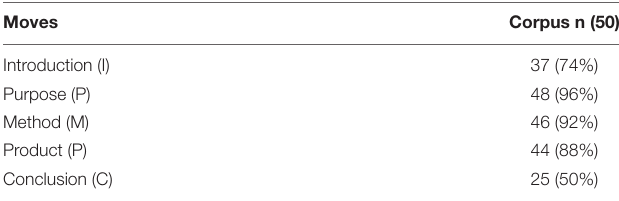
TABLE 2 | The frequency of moves found in the abstracts.